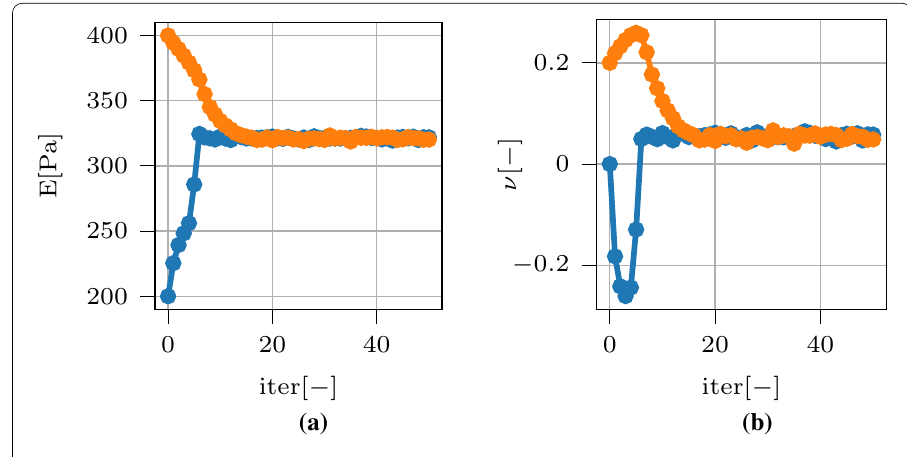
Fig. 12 Result of inverse analysis for added Gaussian noise with σ = 10 − 3 mm. a Young’s modulus E b Poisson’s ratio ν for two different initial guesses